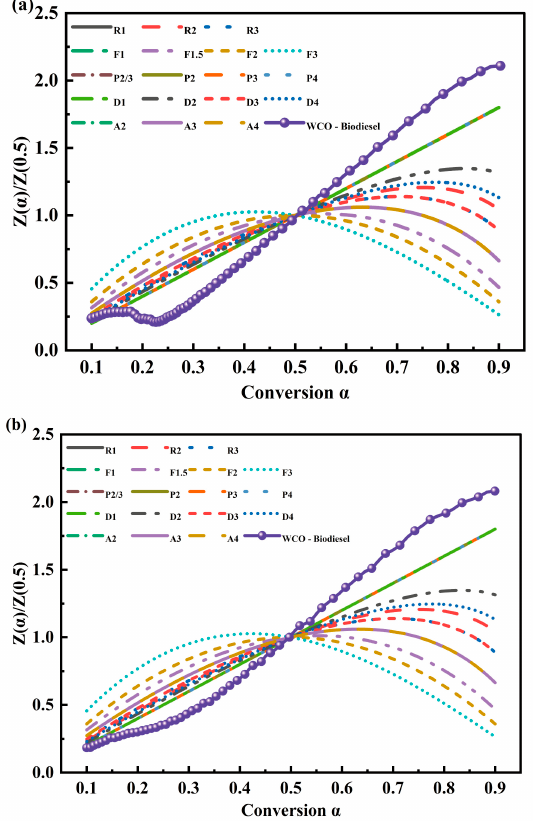
Figure 5. Z( α ) master plots of WCO-Biodiesel pyrolysis under the influence of CS: ( a ) no CS; ( b ) with